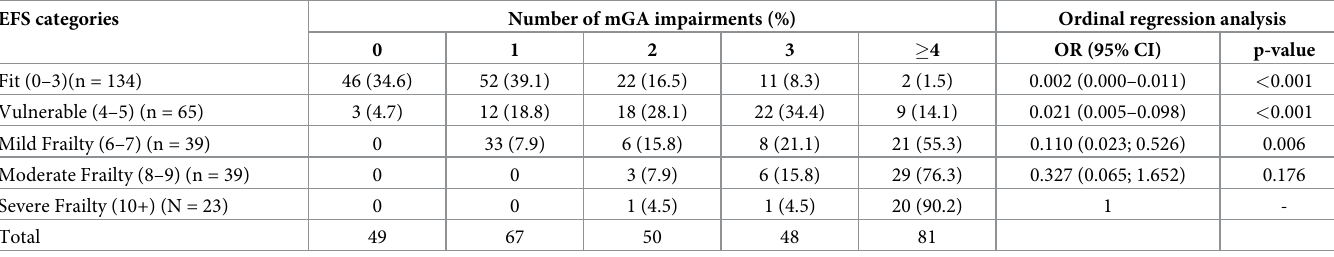
Table 5. Prevalence of mGA impairments according to EFS category, and ordinal logistic regression analysis. EFS